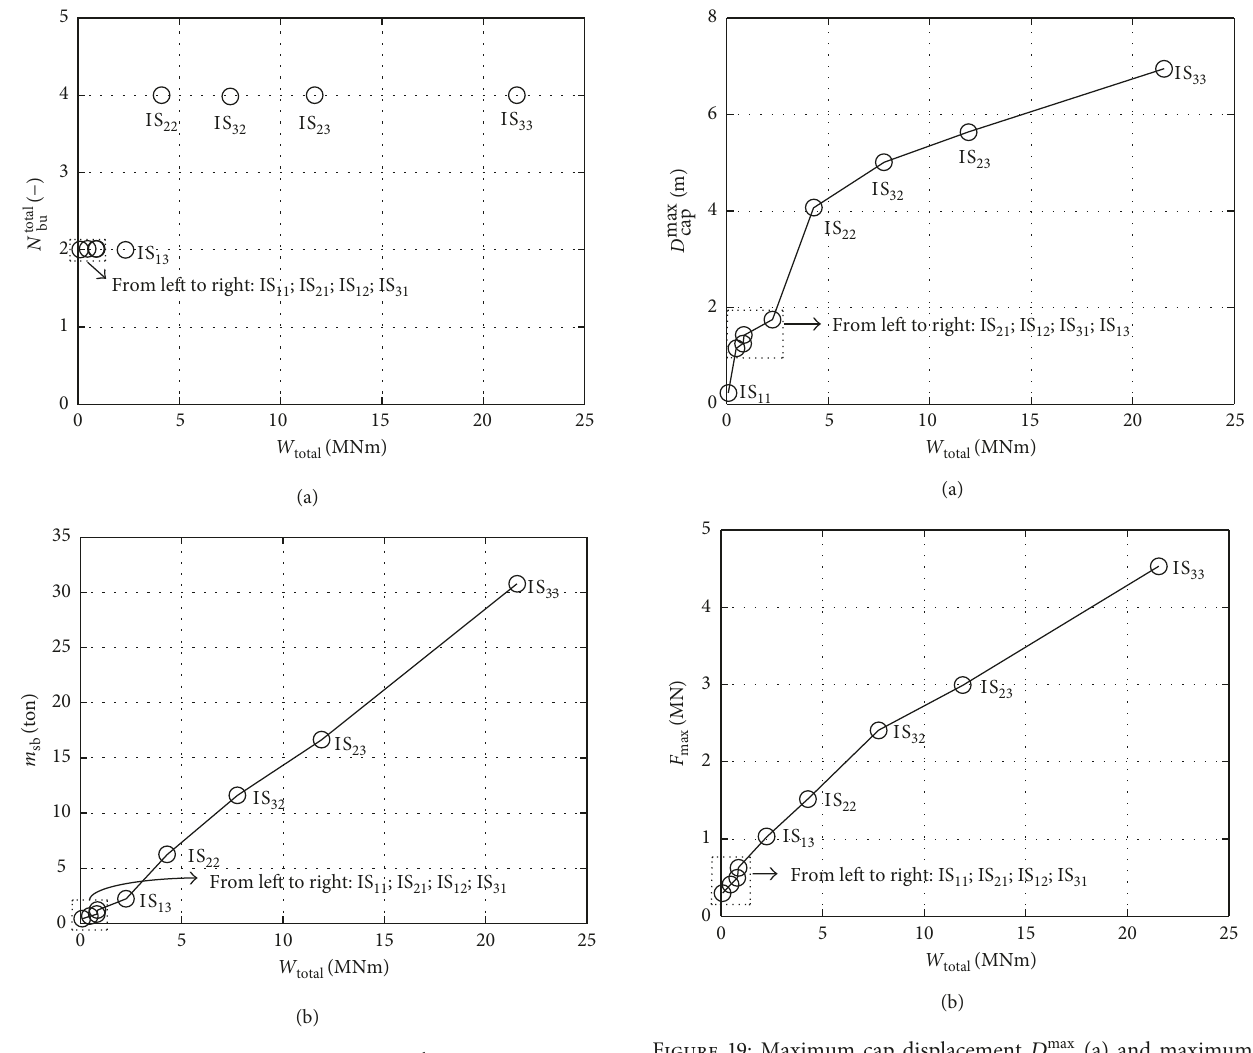
Figure 18: The total number of beam units N total beam steel m sb used by the optimum device versus barge impact energy W N total ( pl (cid:31) 2).